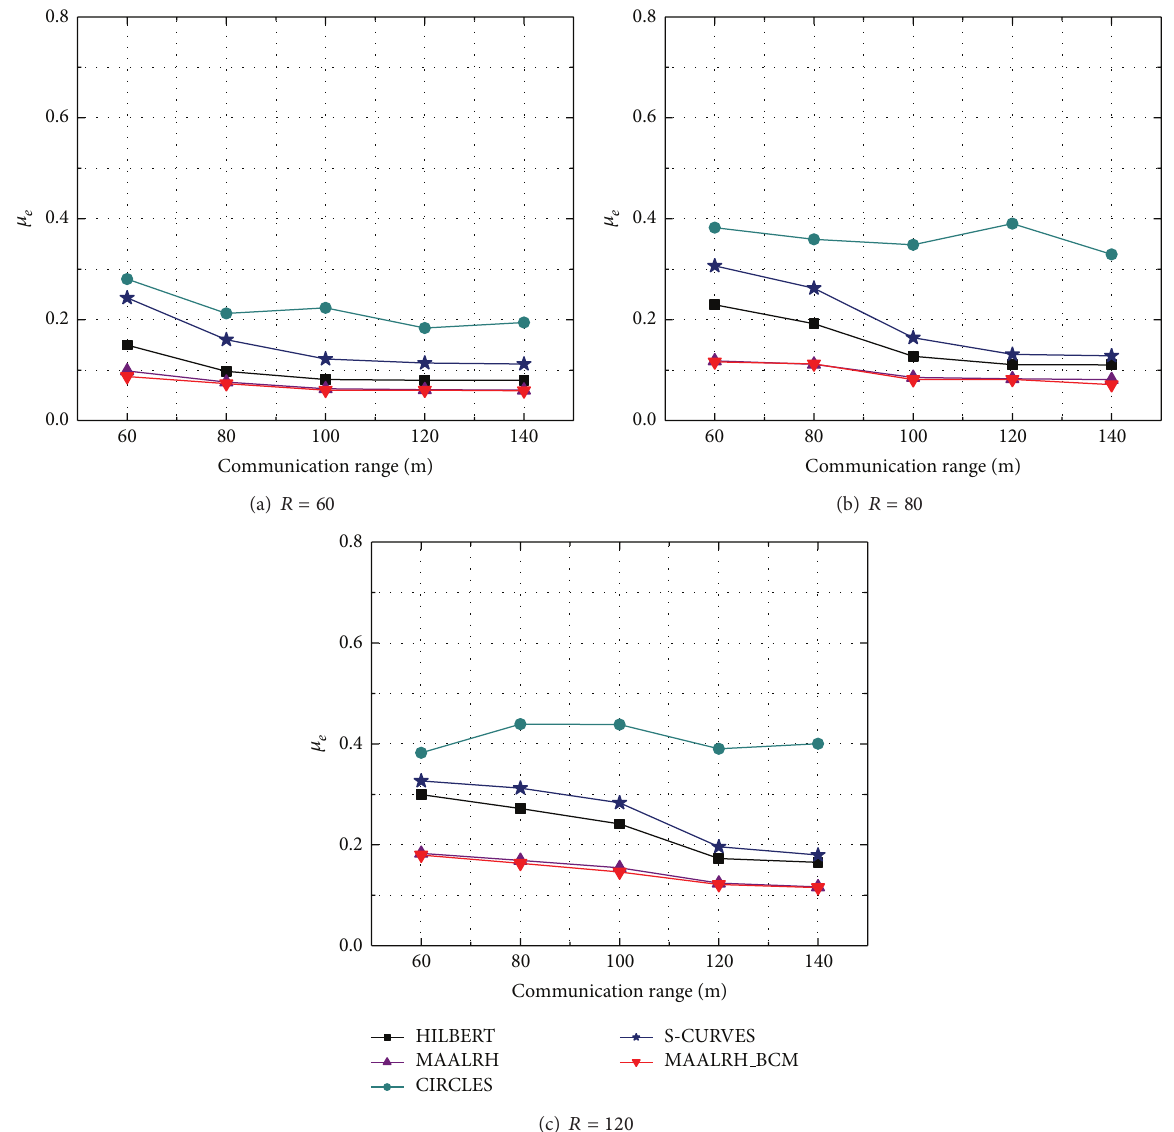
Figure 10: Average deviation with different